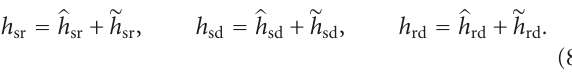
h sr ∼ CN (0, σ sr2 ), h sd ∼ CN (0, σ 2